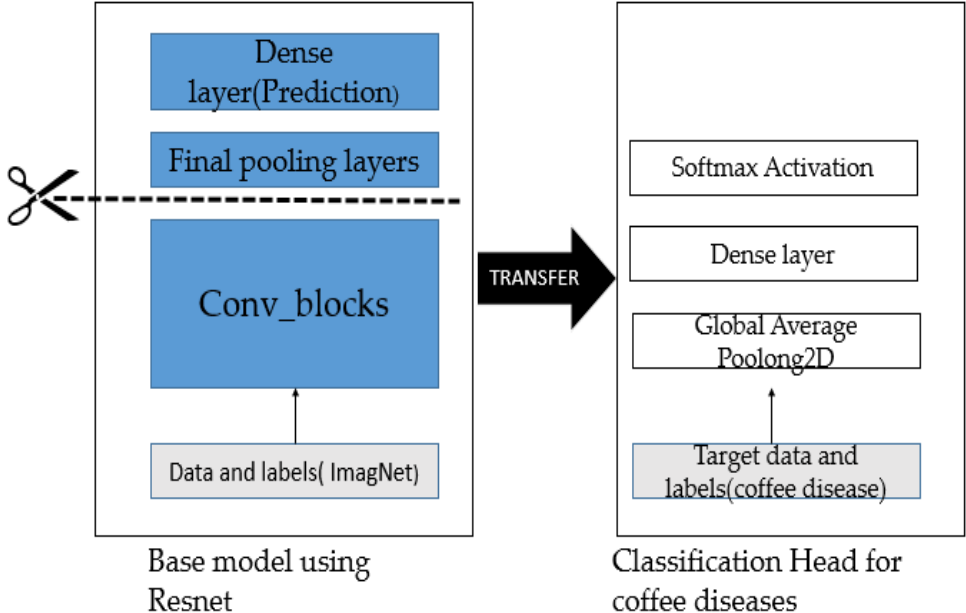
Figure 4. Deep Neural Network model (DNN-model).